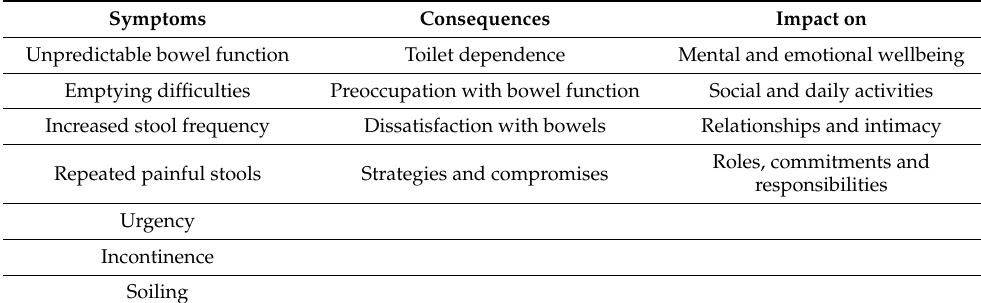
Table 2. LARS Symptoms and Consequences [34].